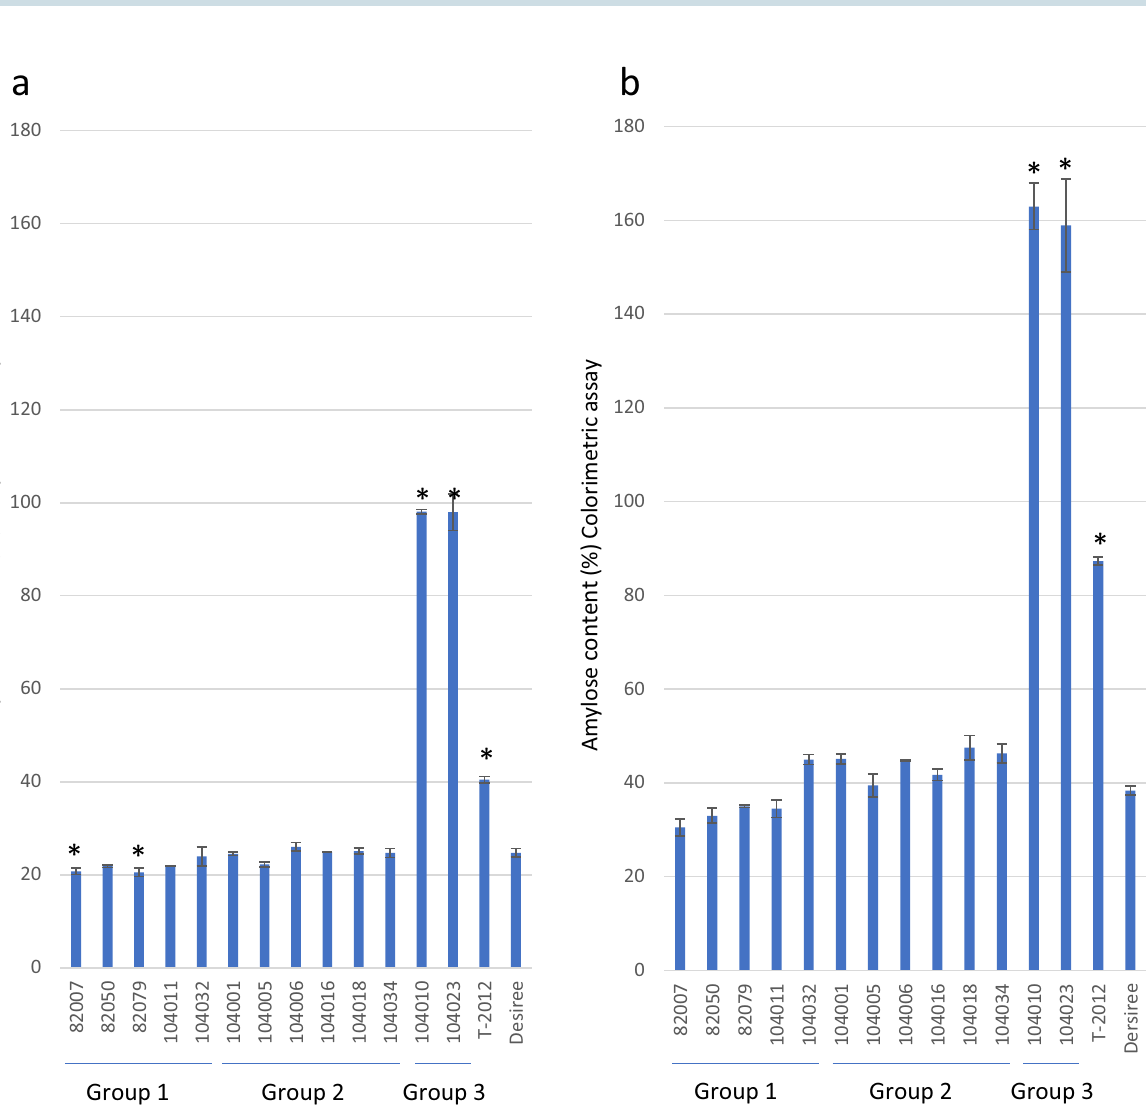
Figure 1. Amylose content of extracted starches measured using a. enzymatic assay and b. colorimetric assay. The results are a mean of two technical replicates, error bar represents standard deviation (s.d.). Values that differ from the parental variety Desiree by Dunnett’s test (P < 0.05) are marked with